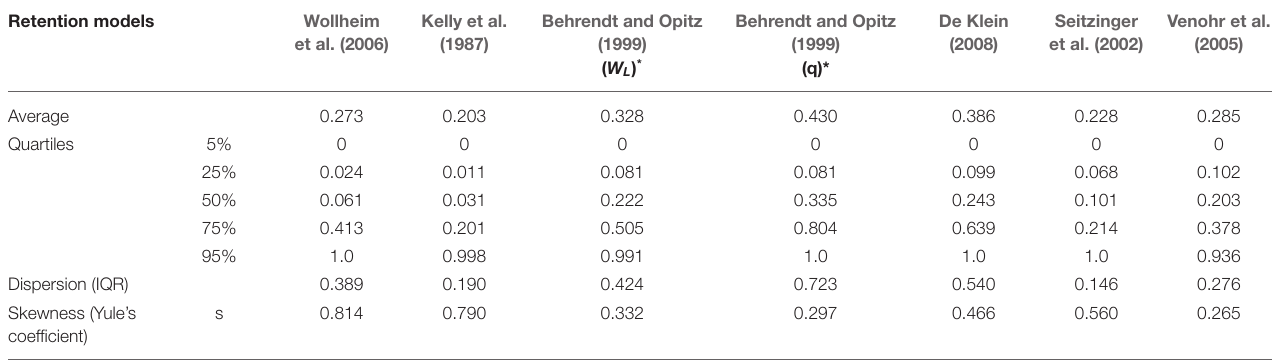
TABLE 4 | Descriptive statistics of N retention of different retention models.